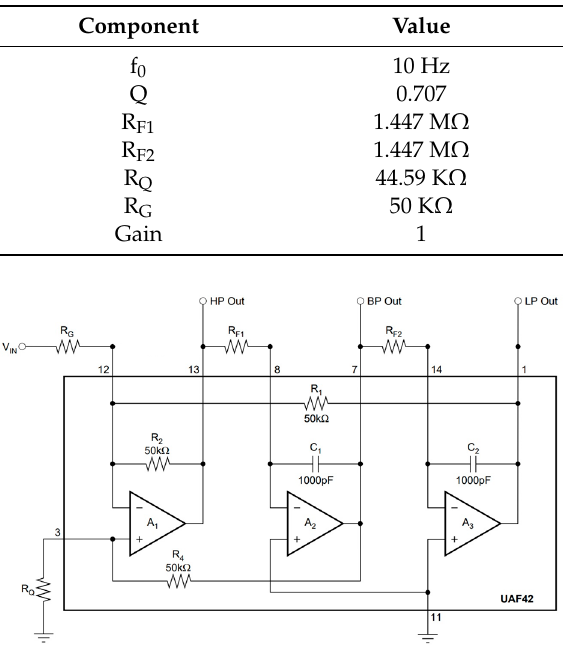
Table 2. Values obtained for the high-pass filter of 10 Hz with the Filter 42 program.